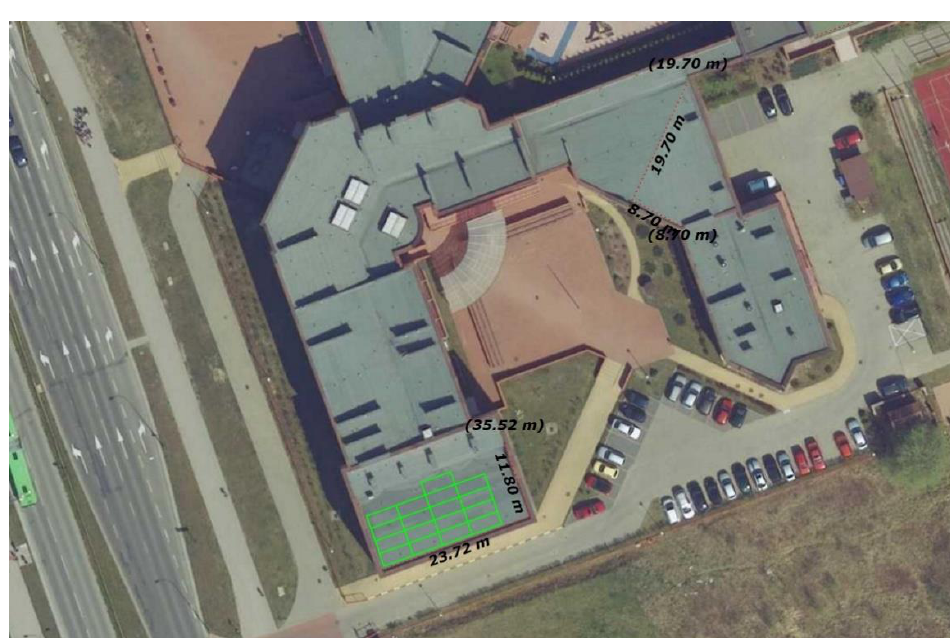
Figure 10. Arrangement of solar collectors on the roof (17 pcs). Table 5. Energy demand and generation before and after installation of the RES